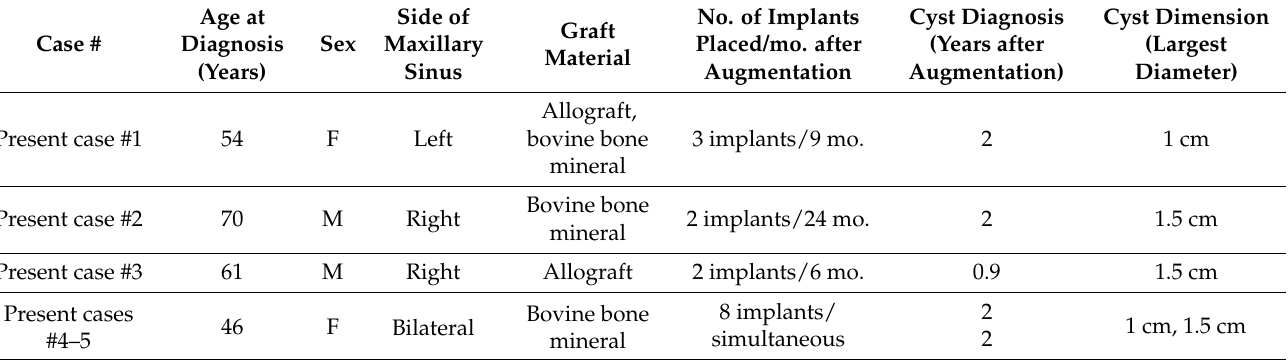
Table 1. Compilation of cases of surgical ciliated cysts (SuCCs) from our